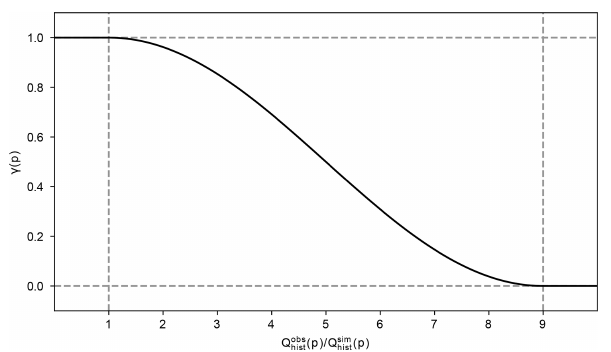
Figure 2. Function γ(p) used to transition from multiplicative to additive trend preservation in mixed trend preservation (Eqs.